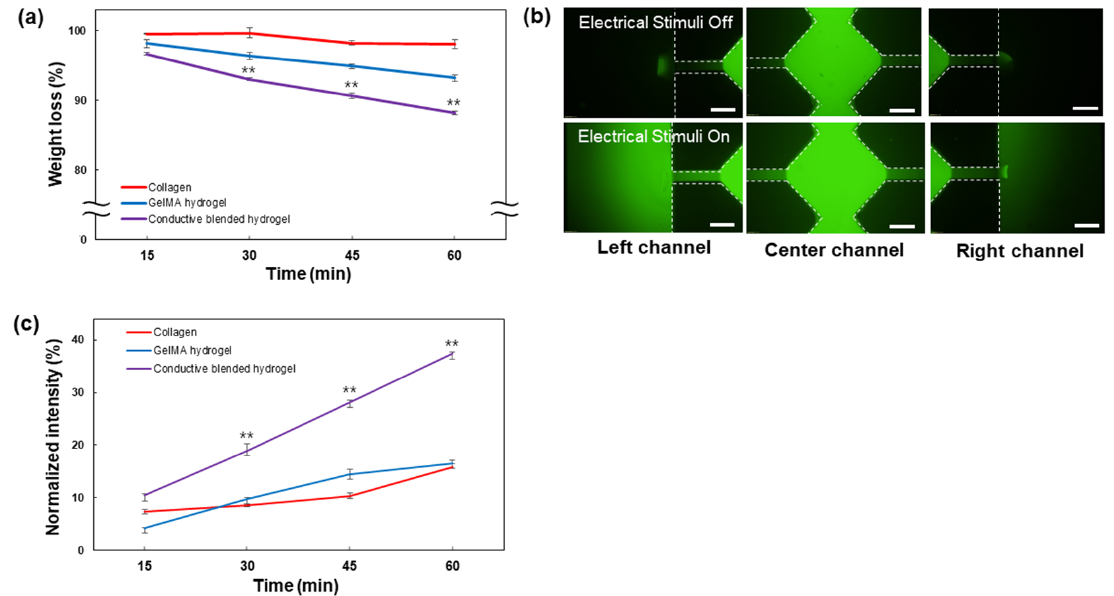
Figure 5. Analysis of the molecule release of the conductive GelMA–collagen–AgNW blended hydrogels. The weight loss analysis of the GelMA–collagen–AgNW blended hydrogel in response to an electrical stimulation (** p < 0.01) ( a ), the diffusion images of the fluorescent molecule in the microfluidic device with an electrical stimulation ( b ), and the diffusion rate of the fluorescent molecule every 15 min with electrical stimulation (** p < 0.01) ( c ). The all scale bars are 300 µm.